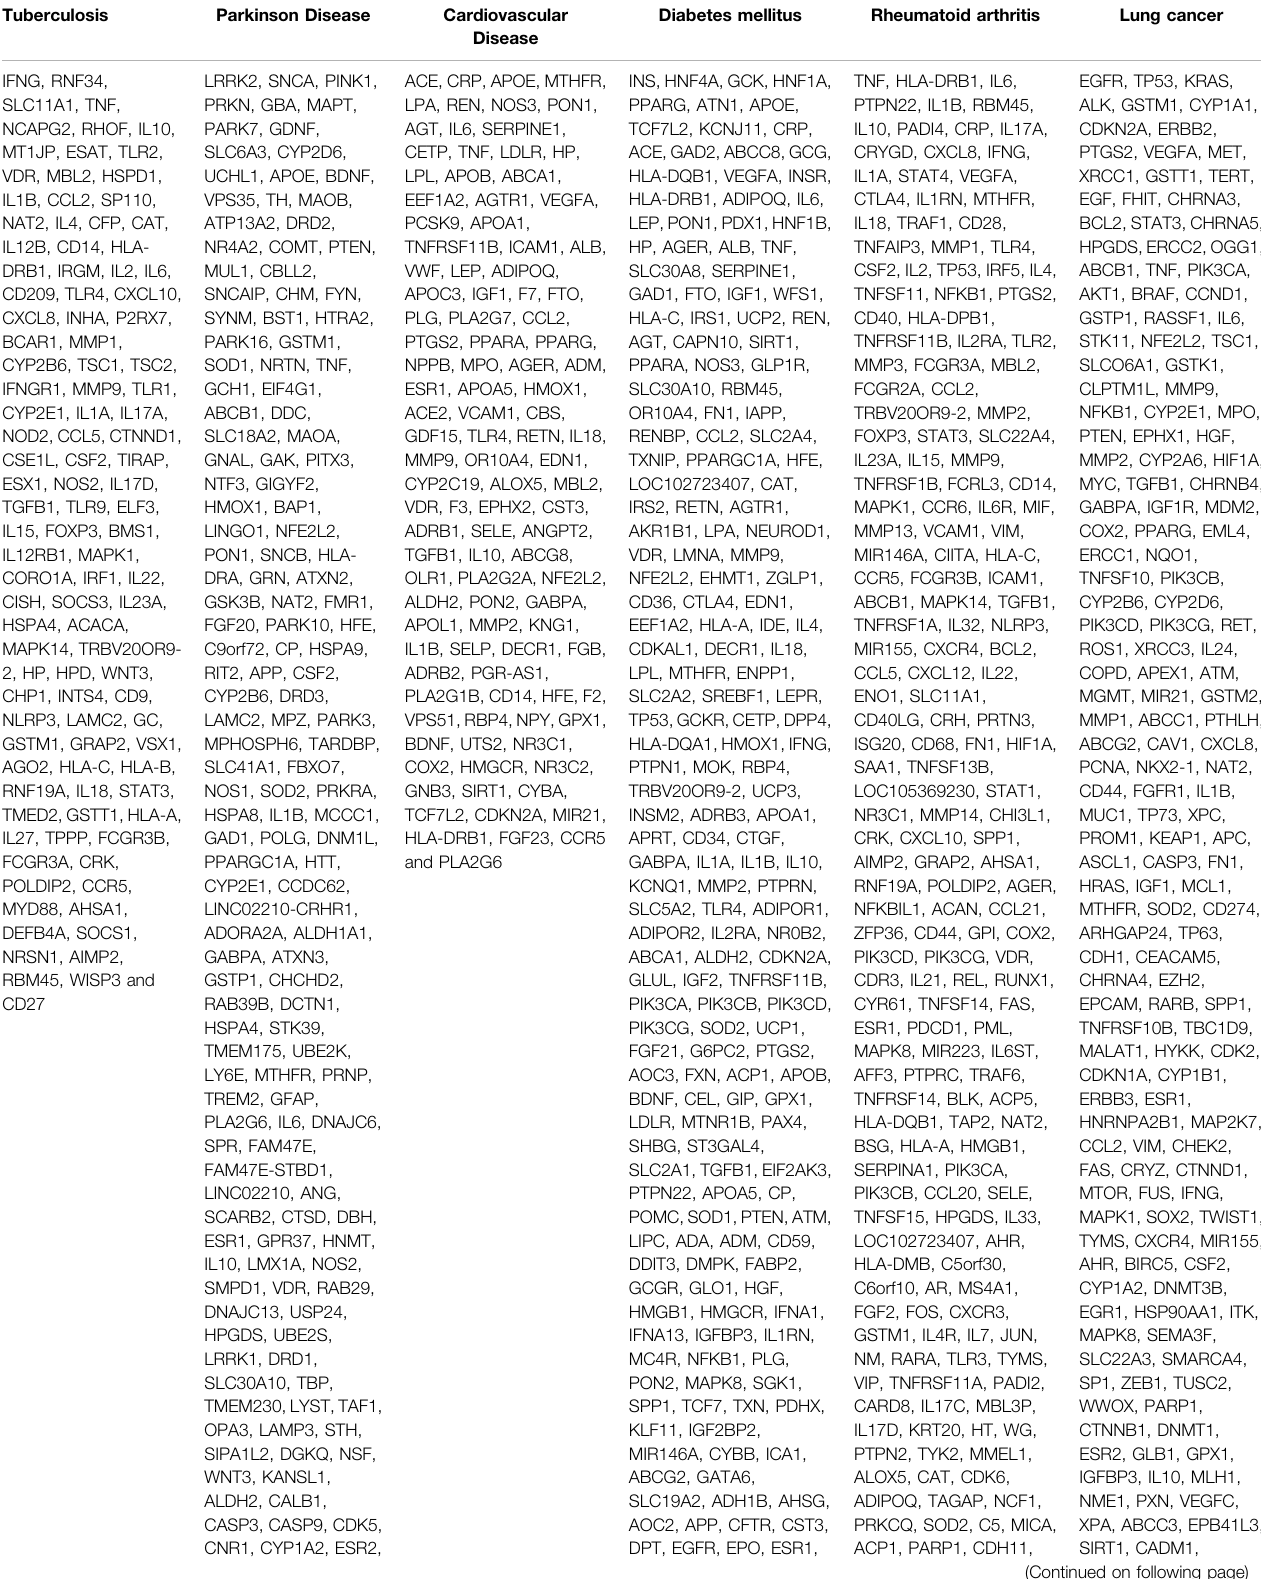
TABLE 1 | List of disease-associated genes. Tuberculosis Parkinson Disease Cardiovascular